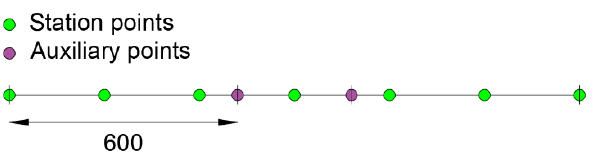
Figure 13. Modeling configuration in the procedure for estimating the plastic zone. In Figure 14, the displacements and curvature diagrams are reported.